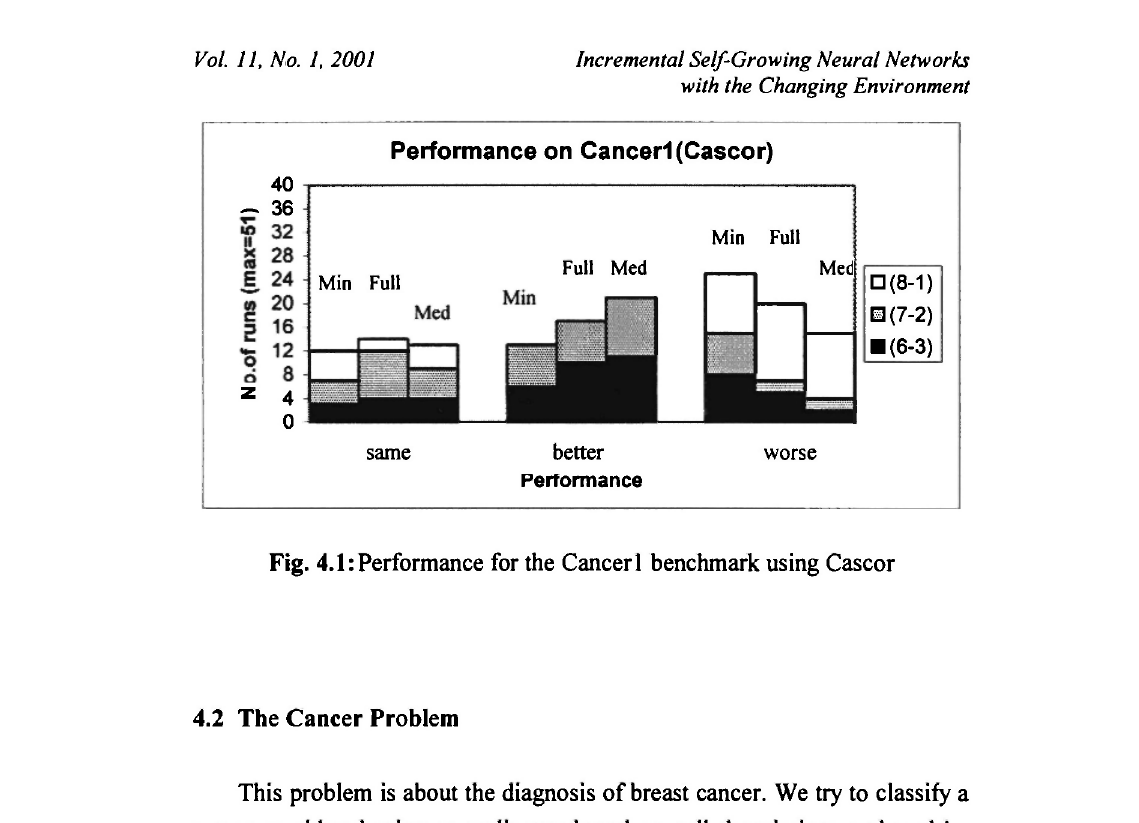
Fig. 4.1 : Performance for the Cancer 1 benchmark using